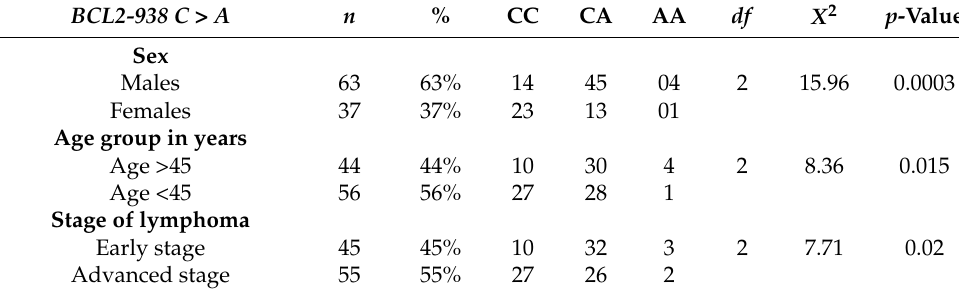
Table 2. Demographic features of Lymphoma patients according to